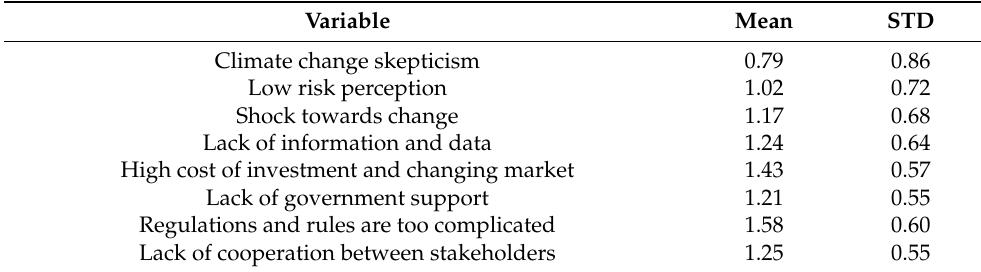
Table 9. Descriptive statistics of climate change adaptation